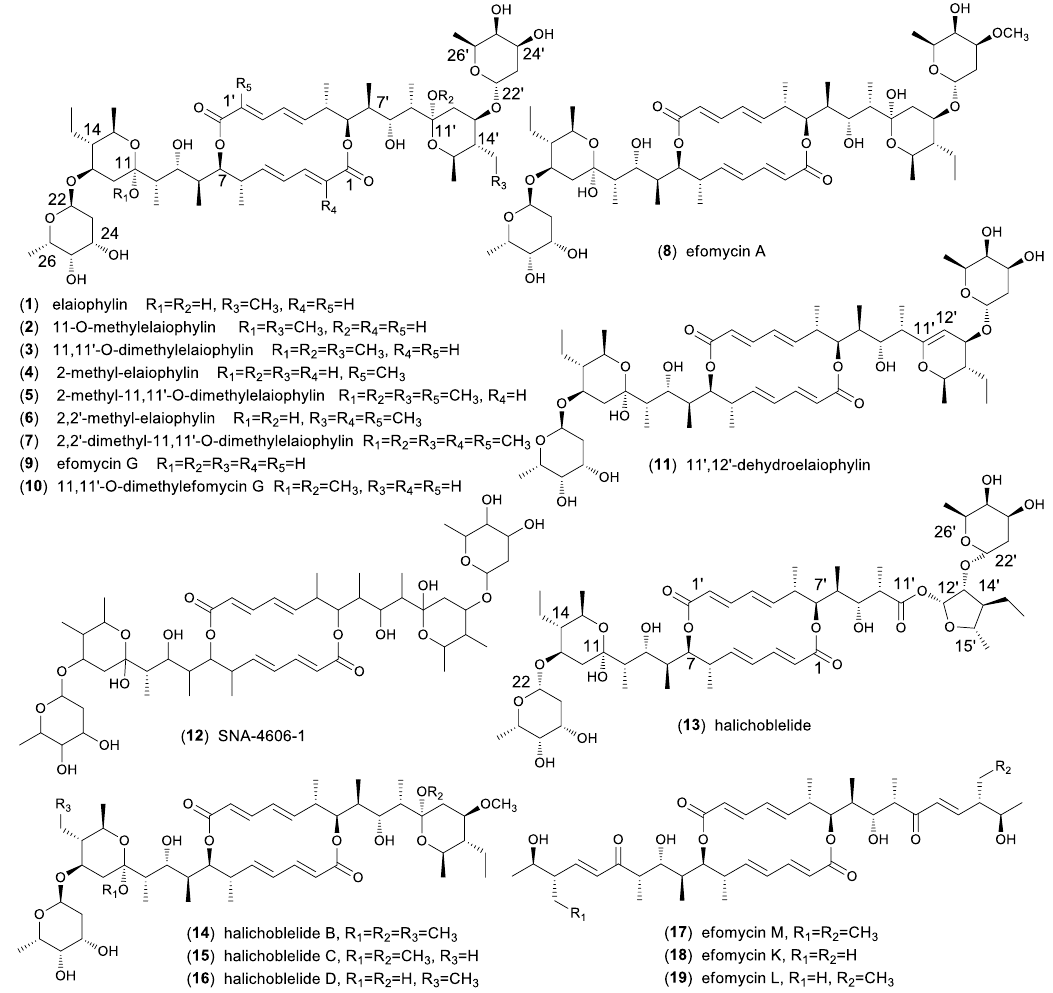
Figure 1. Structures of naturally occurring elaiophylins.